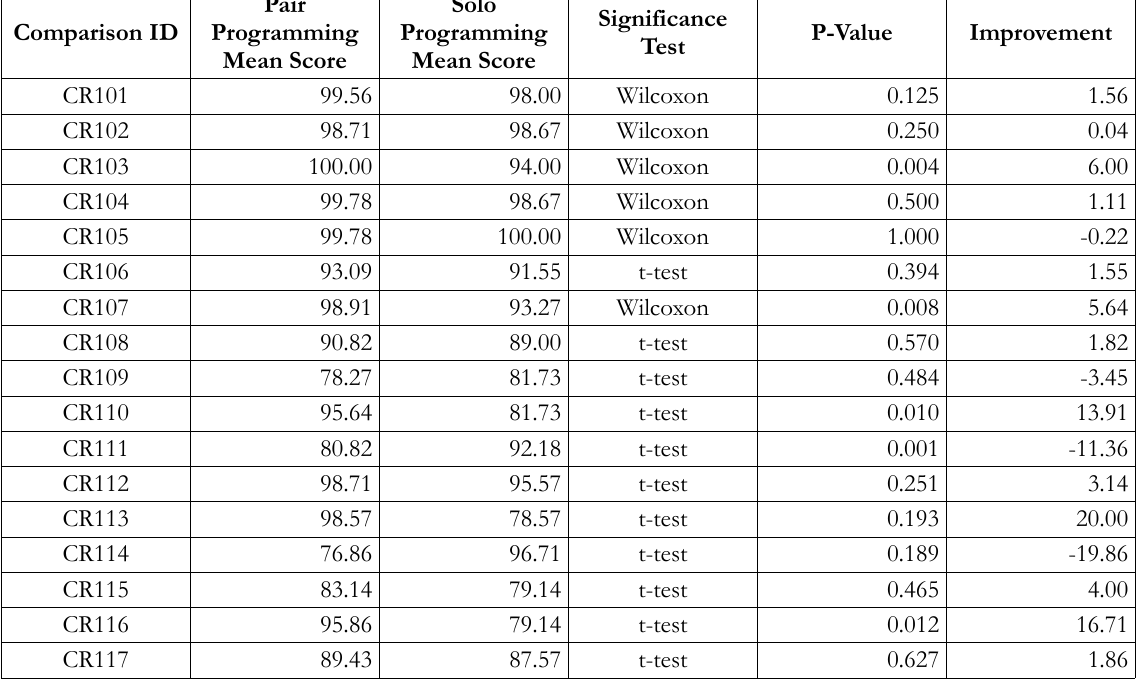
Table 10. The Improvements Gained by Utilising Pair Programming for Fast-Paced